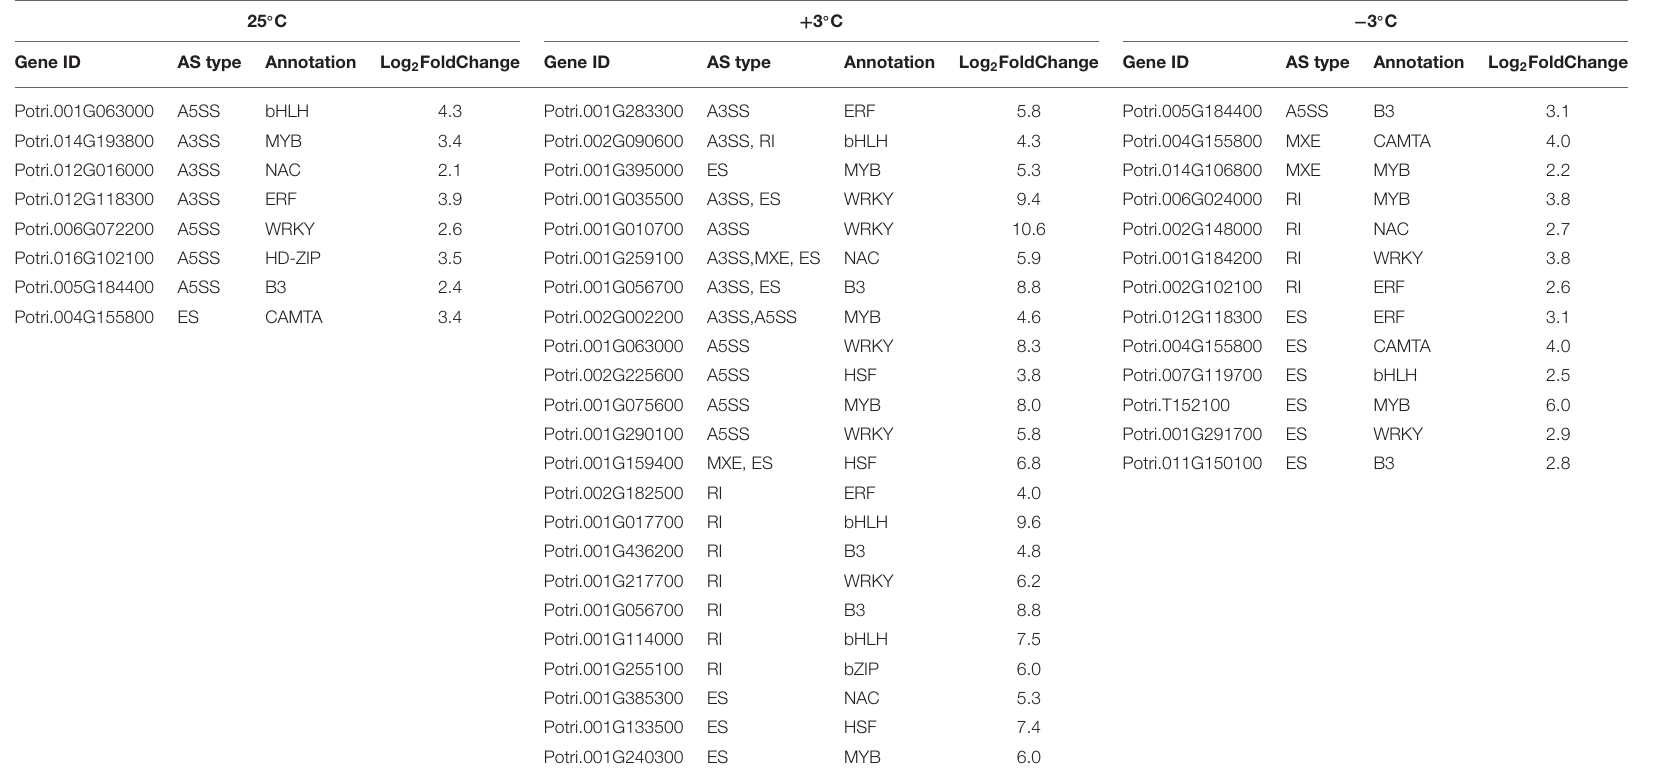
TABLE 6 | Comparison of alternative splicing (AS) events in differentially expressed TFs of two poplar species by the PacBio sequencing data, respectively. 25 ◦